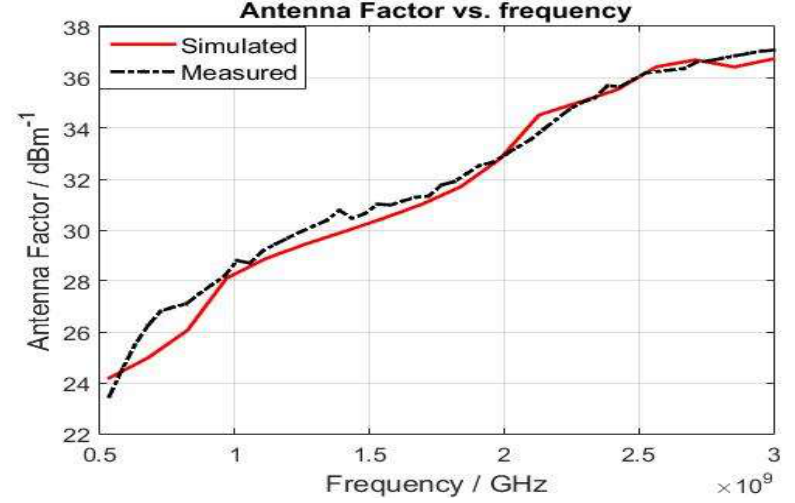
Figure 15. Antenna factor in dBm − 1 vs. frequency for printed biconical antenna.